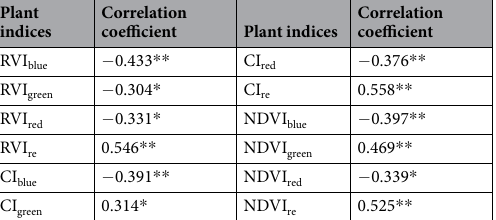
Table 4. The correlation coefficient of plant parameters and chlorophyll content. Note: ** significant at 0.01 level; * significant at 0.05 level.